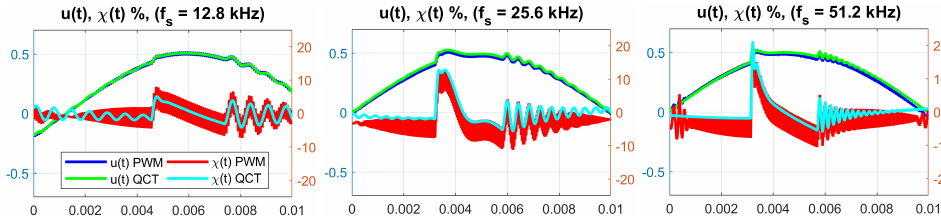
Figure 9. Control signal u ( t ) and deviation function χ ( t ) obtained from the QCT simulation and PWM simulation.